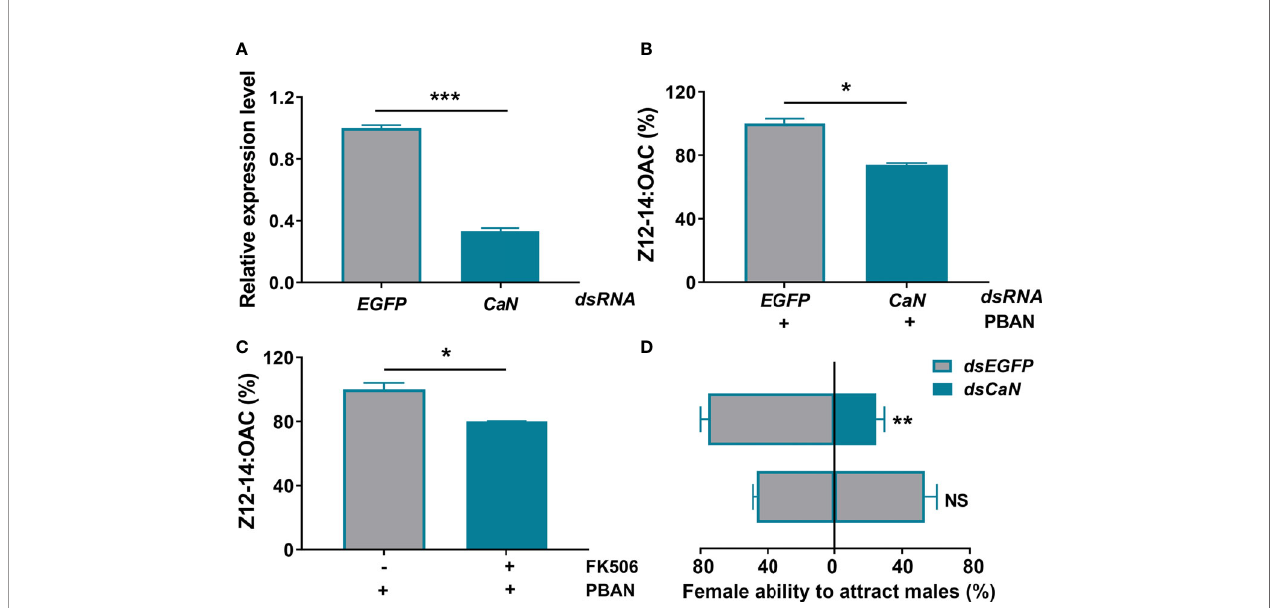
FIGURE 4 | CaN positively regulates sex pheromone biosynthesis in O. furnacalis PGs. (A) The effects of dsRNA injection on the expression of CaN transcript. (B) Effect of ds CaN knockdown on sex pheromone production in O. furnacalis PGs. (C) Effect of the CaN inhibitor FK506 on sex pheromone production in O. furnacalis PGs. (D) Effect of ds CaN knockdown on female capability to attract males. Data represent the mean ± SE (n = 3). Statistically signi fi cant differences were denoted with * ( P < 0.05), ** ( P < 0.01), and *** ( P < 0.001) as determined by Student ’ s t -test. NS, not signi fi cant.